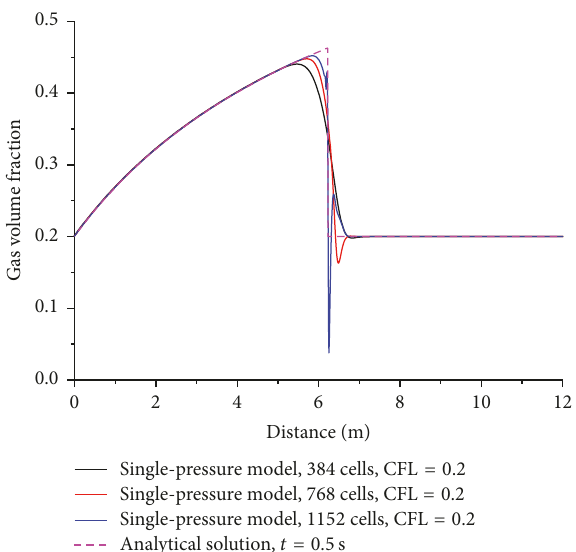
Figure 6: Numerical results of gas volume fraction using single- pressure model and FOU scheme with finer cells at time of 0.5 seconds.